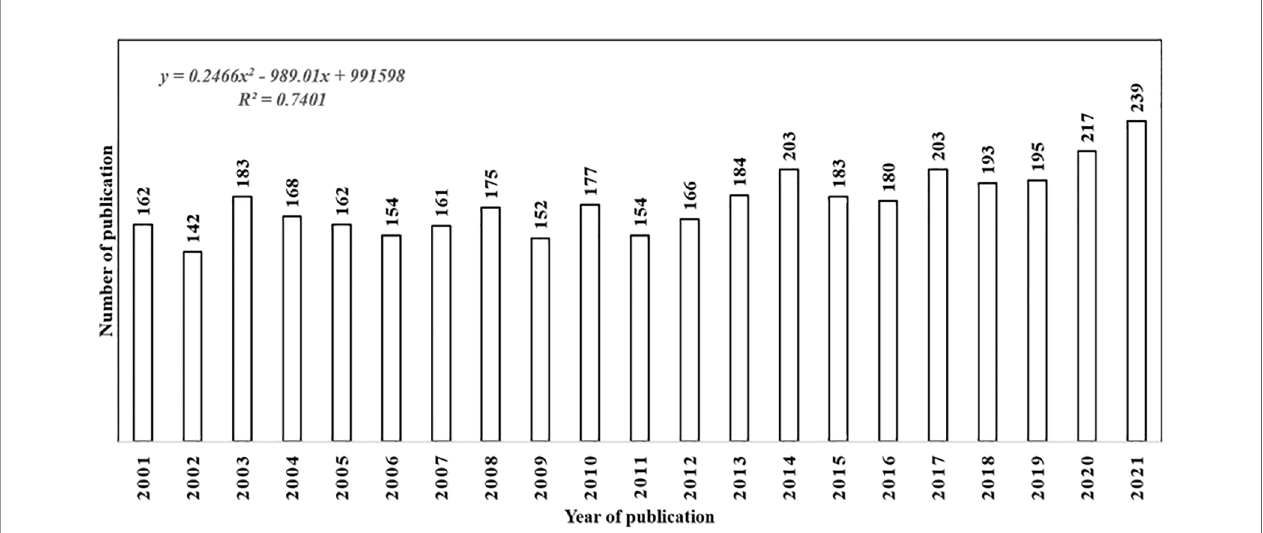
FIGURE 1 | Annual number of publications relating to capsaicin research in the period 2001 –